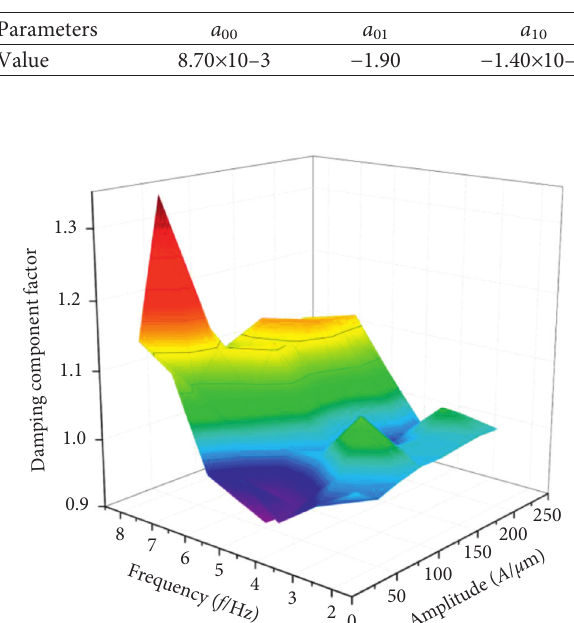
. 3 Figure 13: The space surface of damping component factor n ( A , f